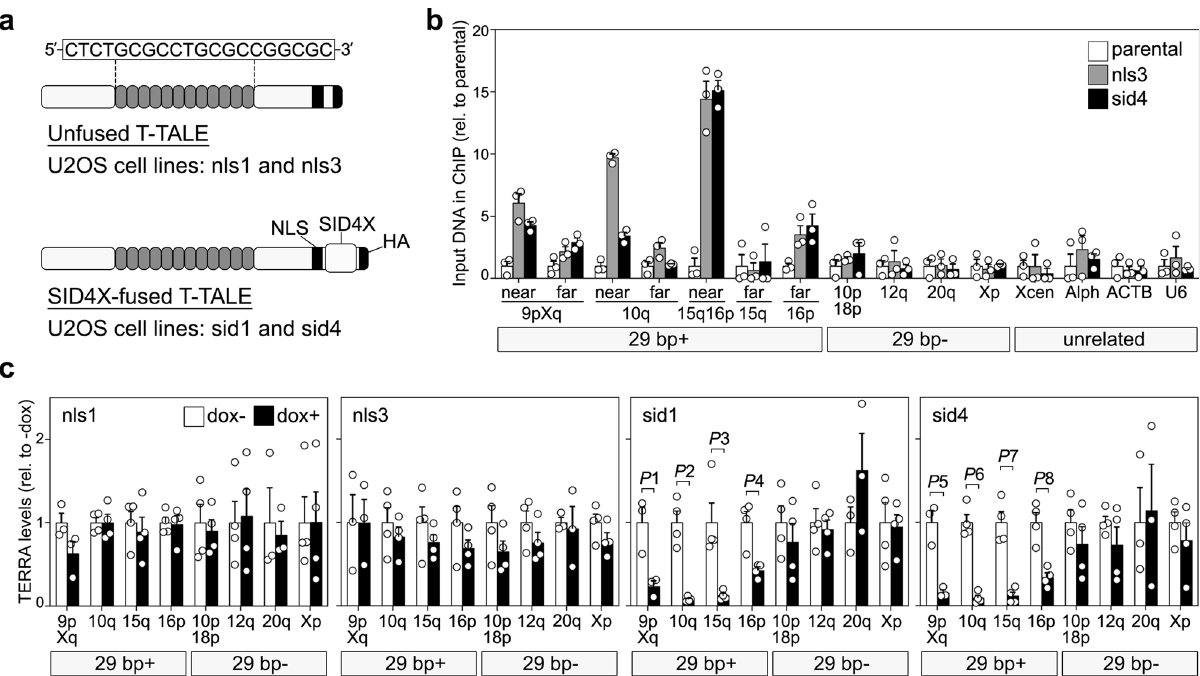
Fig. 1 Development and validation of T-TALEs. a Schematic representation of T-TALEs. The RVD domain recognizing the indicated nucleotides within the 29 bp repeat consensus sequence is represented by gray rounded rectangles. NLS: nuclear localization signal; SID4X: four transcription repressor domains of the mSIN3 interaction domain; HA: human in fl uenza hemagglutinin tag. b Quanti fi cation of anti-HA ChIPs in the indicated cell lines (parental: T-Rex- U2OS) treated with dox for 24 h. QPCRs were performed with oligonucleotides amplifying subtelomeric regions from chromosome ends containing or devoid of 29 bp repeats (29 bp + and 29 bp − , respectively). For 29 bp + subtelomeres, two oligonucleotide pairs placed at different distances from the 29 bp array were used and are indicated as near and far. The distances of each amplicon from 29 bp repeats and/or telomeric repeats are shown in Supplementary Table 1. Control qPCR was performed with oligonucleotides amplifying sequences from a unique region of the X chromosome centromere (Xcen), alphoid DNA (Alph), and beta Actin (ACTB) and U6 gene loci. Values are graphed as input DNA found in the corresponding ChIP samples normalized to U2OS parental samples. Bars and error bars are means and SEMs from three independent experiments. Circles are single data points. c RT- qPCR quanti fi cations of TERRA transcripts from 29 bp + and 29 bp − chromosome ends in the indicated cell lines, treated with dox for 24 h or left untreated. Values are graphed normalized to − dox. Bars and error bars are means and SEMs from 3 independent experiments for 9pXq and 20q and from 4 independent experiments for the remaining chromosome ends. Circles are single data points. P- values were calculated with a two-tailed Student ’ s t -test. P 1 = 0.01886; P 2 = 0.0065; P 3 = 0.0325; P 4 = 0.0059; P 5 = 0.00442; P 6 < 0.0001; P 7 = 0.0006; P 8 = 0.0022. Source data are provided as a Source Data fi